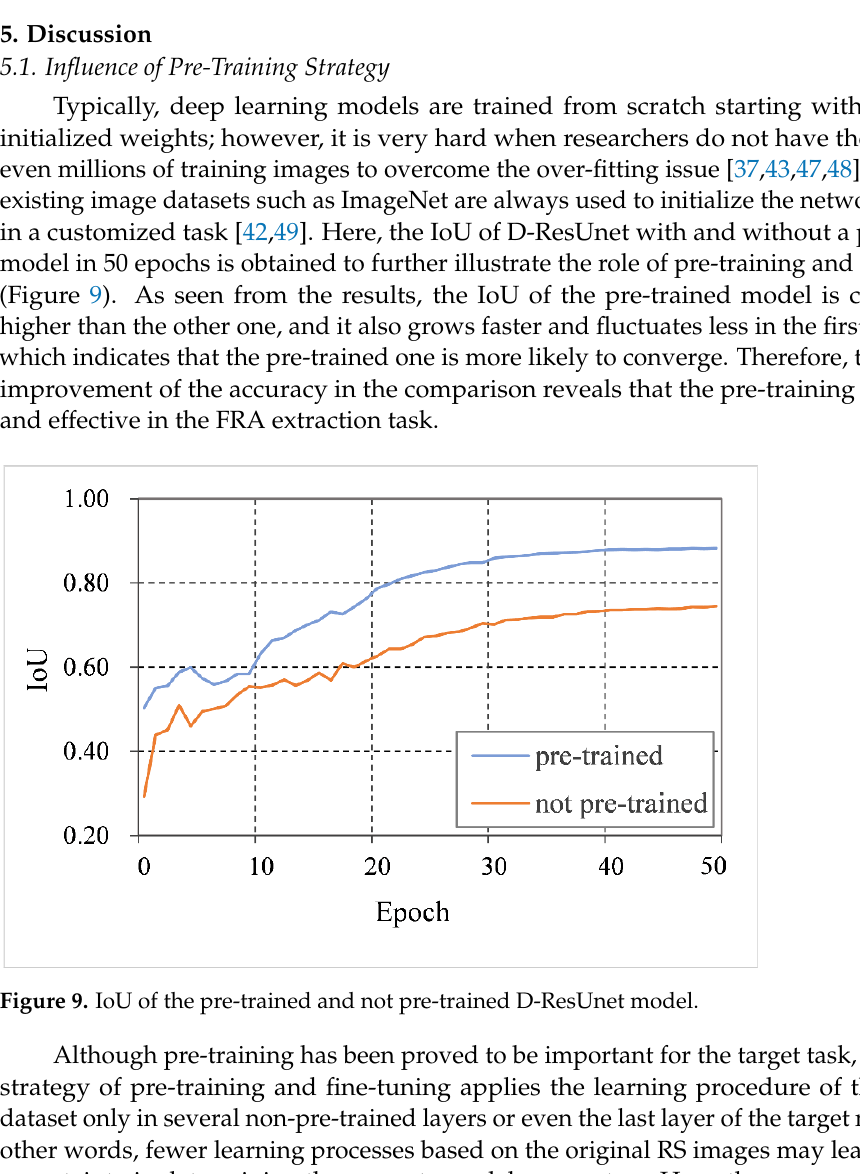
Table 7. The Precision, Recall, F1, and IOU of the models (Mean ± SD 1 ). Methods